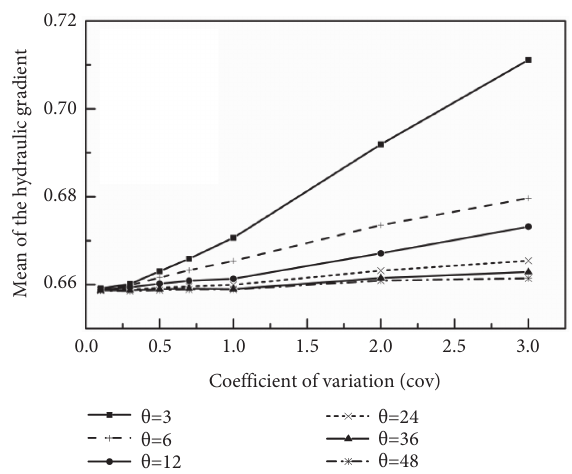
Figure 8: Variation of the mean of hydraulic gradient with hy- draulic conductivity for different values of COV.